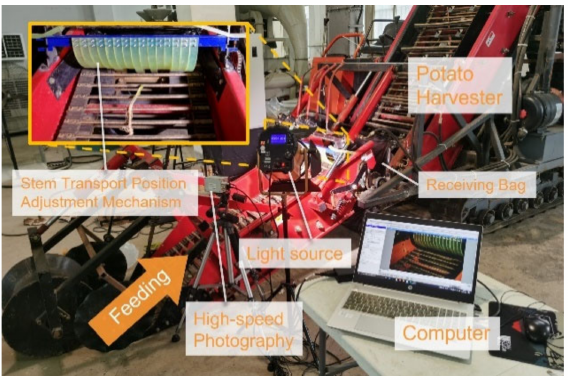
Figure 4. The stem transported-posture adjustment mechanism test bench.